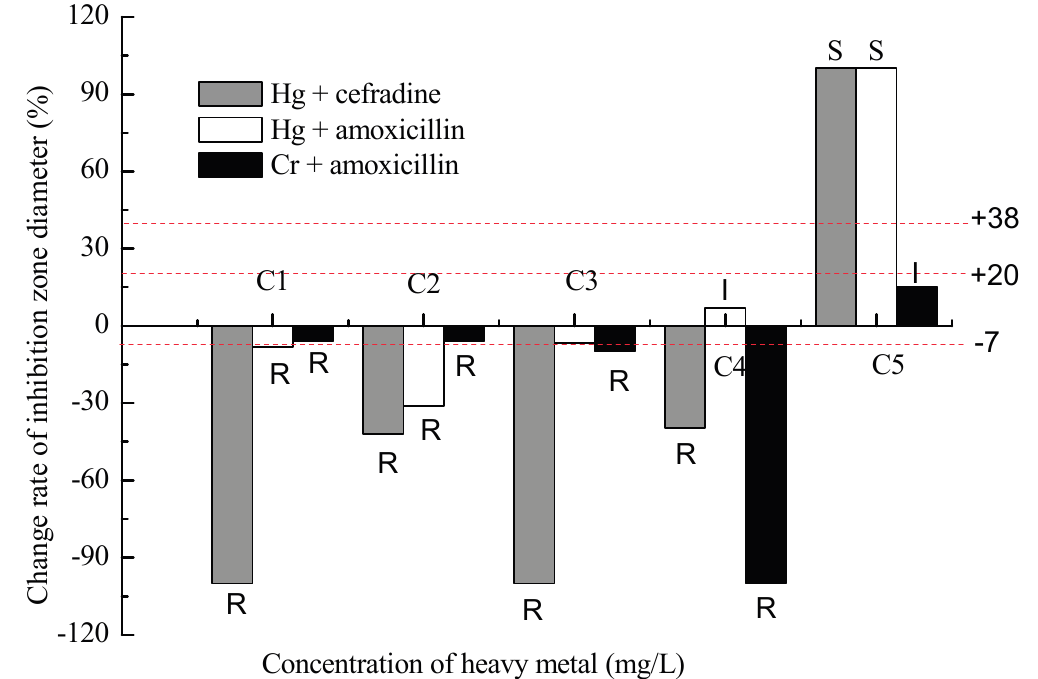
Figure 1. Effect of heavy metals on antibiotic resistance turning from synergistic to antagonistic with their increasing concentration. Each value in Figure 1 is the mean of nine replicates. R (Resistant), I (Intermediate) and S (Sensitive) of the CLSI category were labeled on each column. C1, C2, C3, C4, C5 were the effective concentrations of heavy metal in the medium, that is, Cr 6+ of 0.06, 1.88, 19.18, 46.70, 77.59 mg/L, and Hg 2+ of 0.07, 0.86,